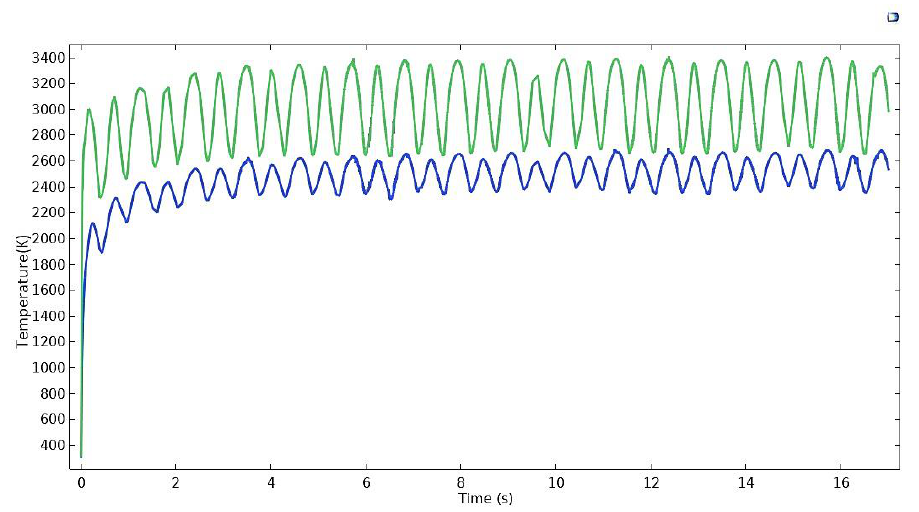
Figure 13. Maximum temperature (computational) on the edge temperature probes along weld line at Z = 0 (green) and Z = − 2.5 (blue).